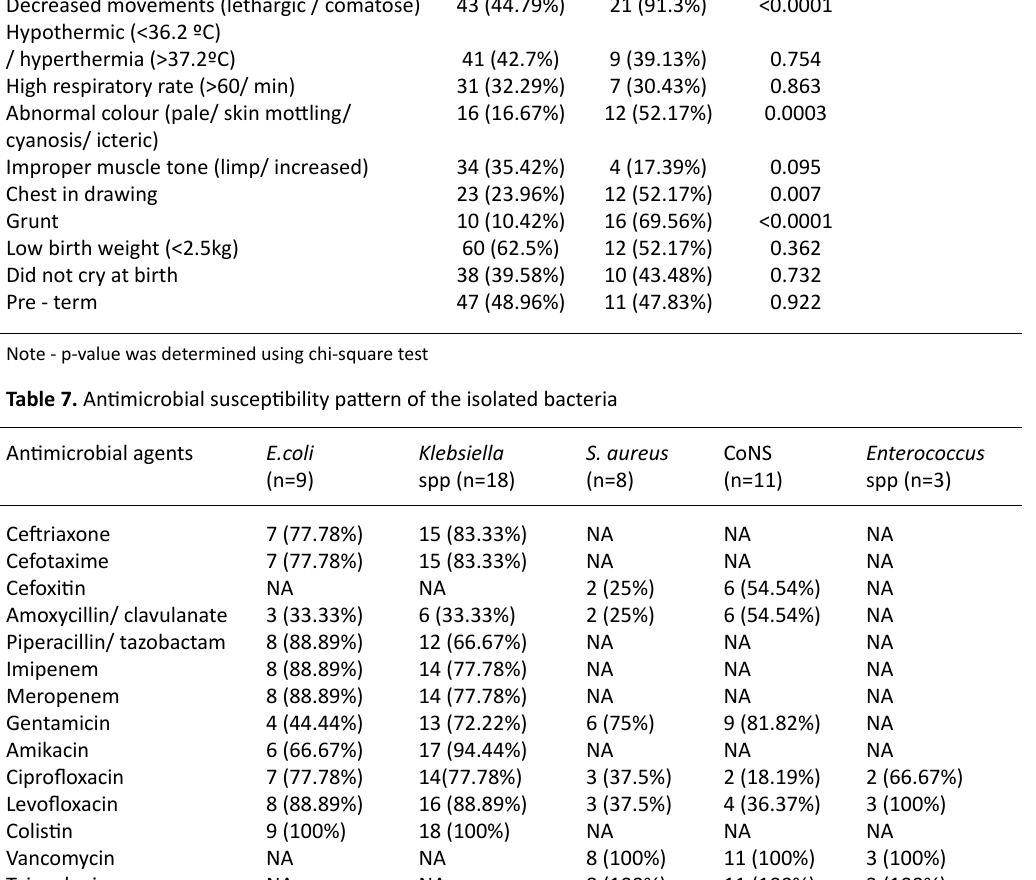
Table 6. Correlation of clinical profile of the patients with outcome Abnormal